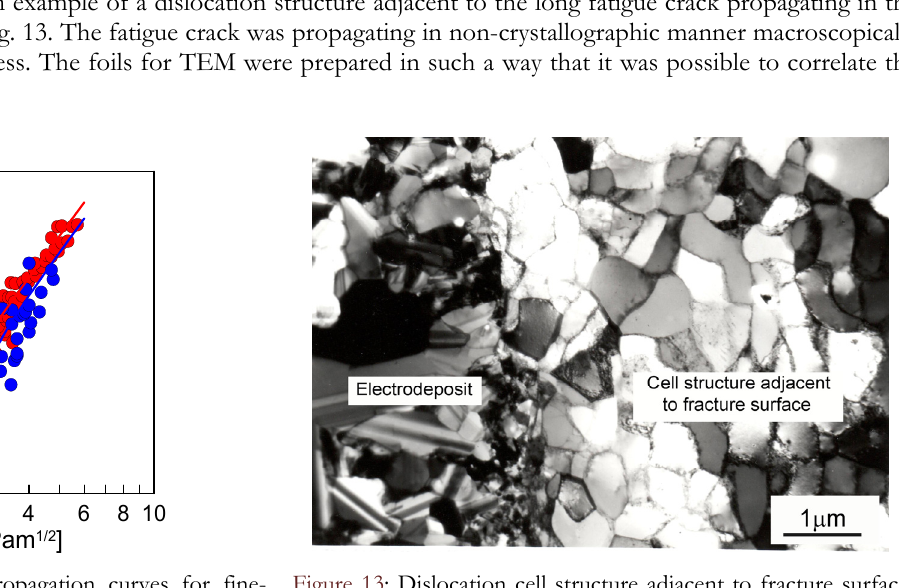
Figure 13: Dislocation cell structure adjacent to fracture surface in conventionally grained